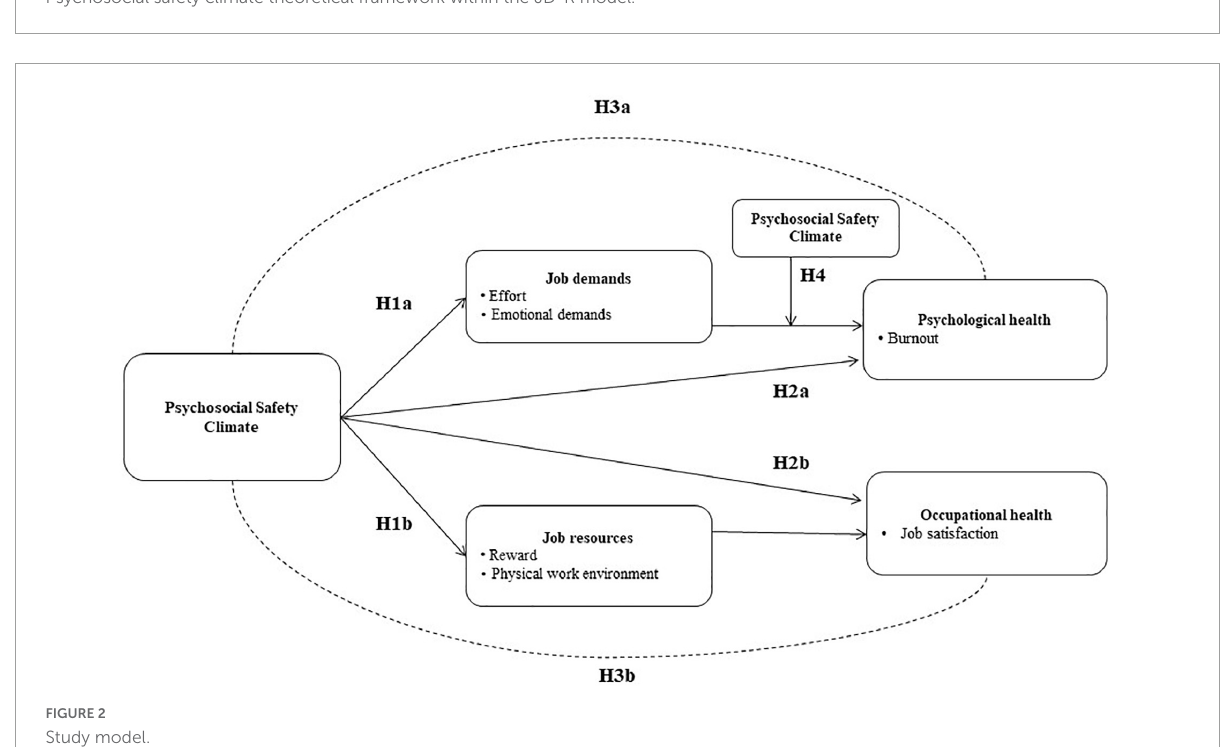
FIGURE1 Psychosocial safety climate theoretical framework within the JD-R model.